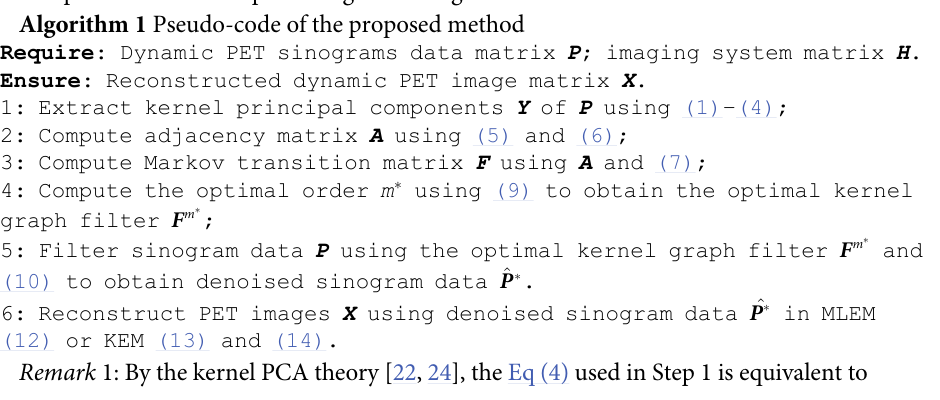
Algorithm 1 Pseudo-code of the proposed